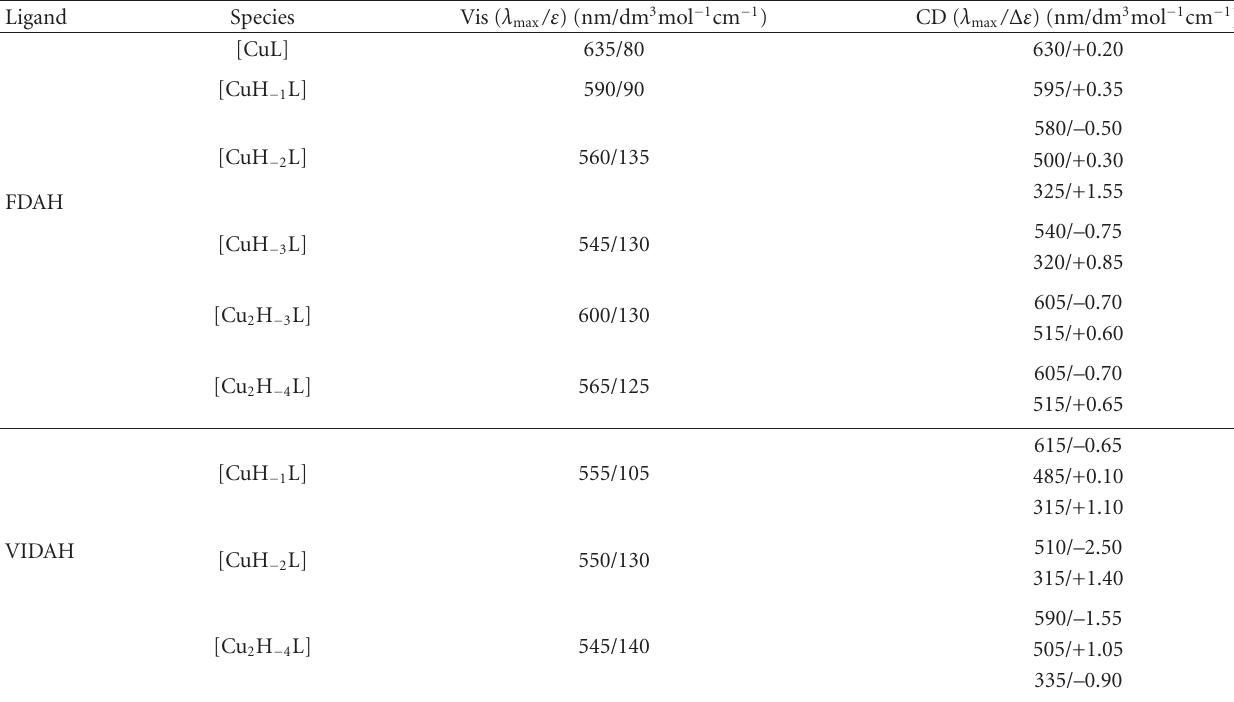
Table 4: Spectroscopic parameters of the major species formed in the copper(II)-FDAH and VIDAH systems.